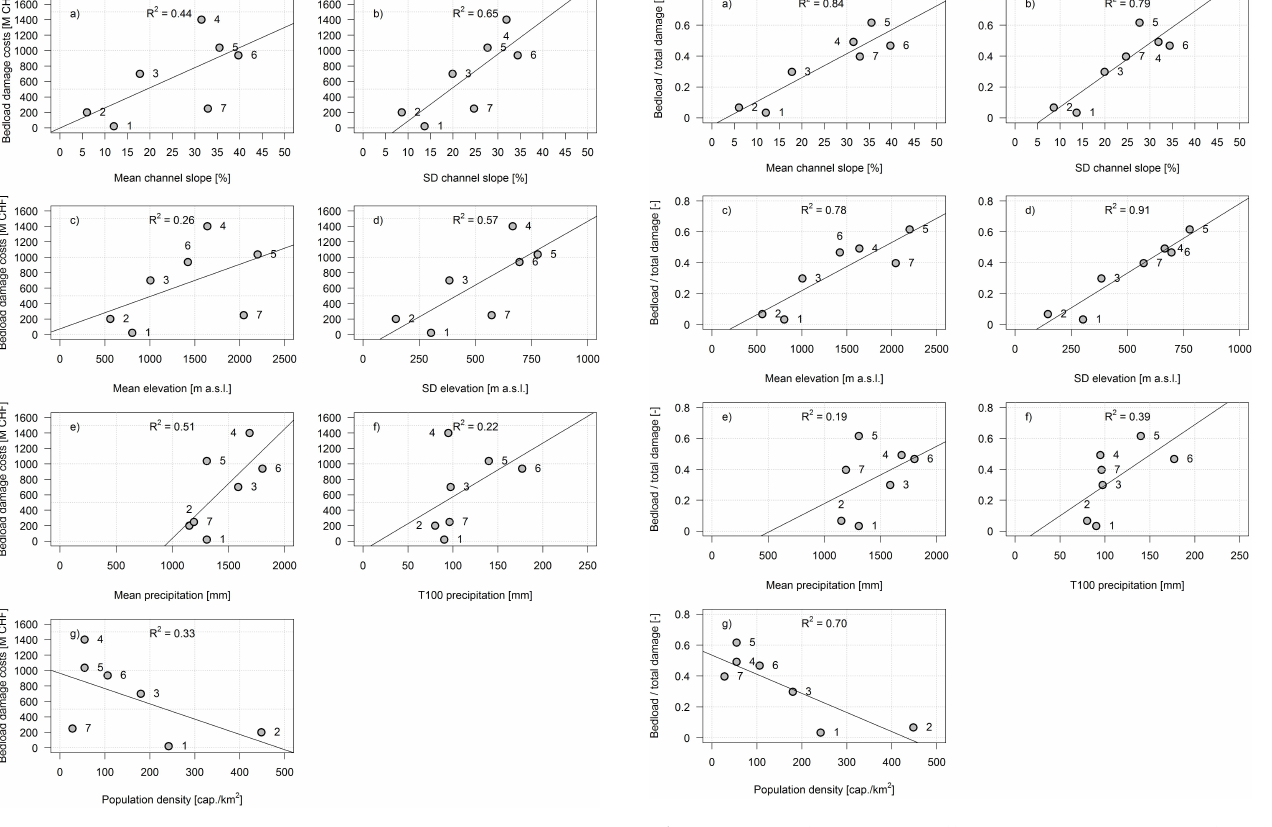
Fig. 6. Relation, for the seven different subareas, between the cumu- lative bedload damage costs and (a) the mean/ (b) standard deviation of channel slope, (c) the mean/ (d) standard deviation of elevation, (e) the mean annual precipitation, (f) the 1-day rainfall with a recur- rence interval of 100yr, and (g) the population density. Note that the average of the lower and upper bedload damage cost estimates was applied. Numbers next to the data points denote subareas according to Table 1 and Fig. 1.